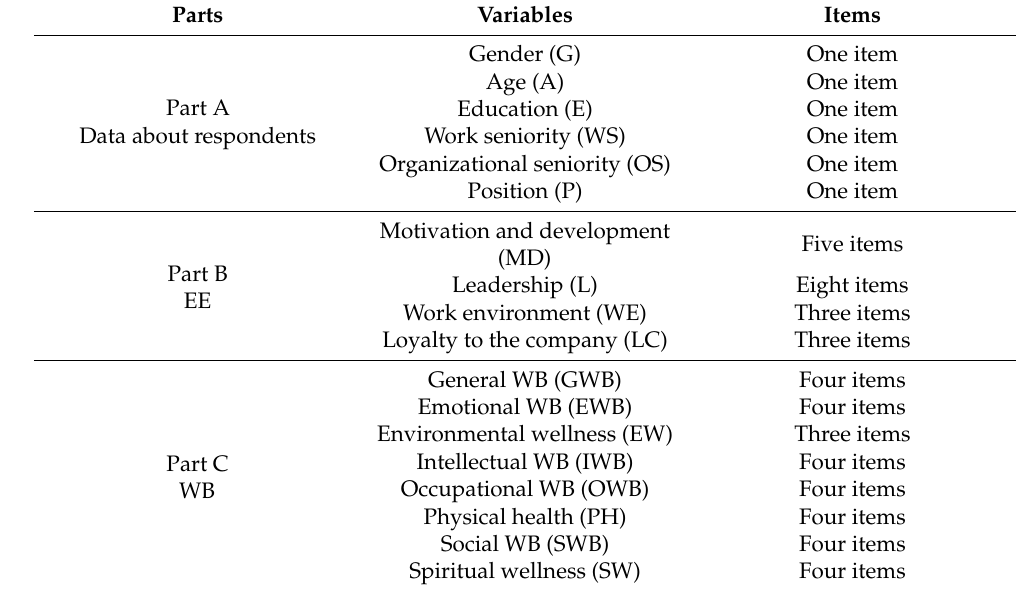
Table 1. Questionnaire structure.